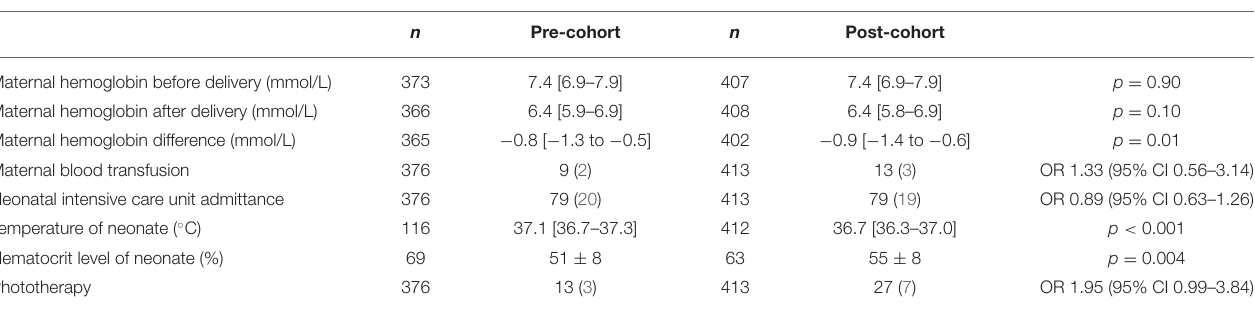
TABLE 3 | Secondary outcomes.